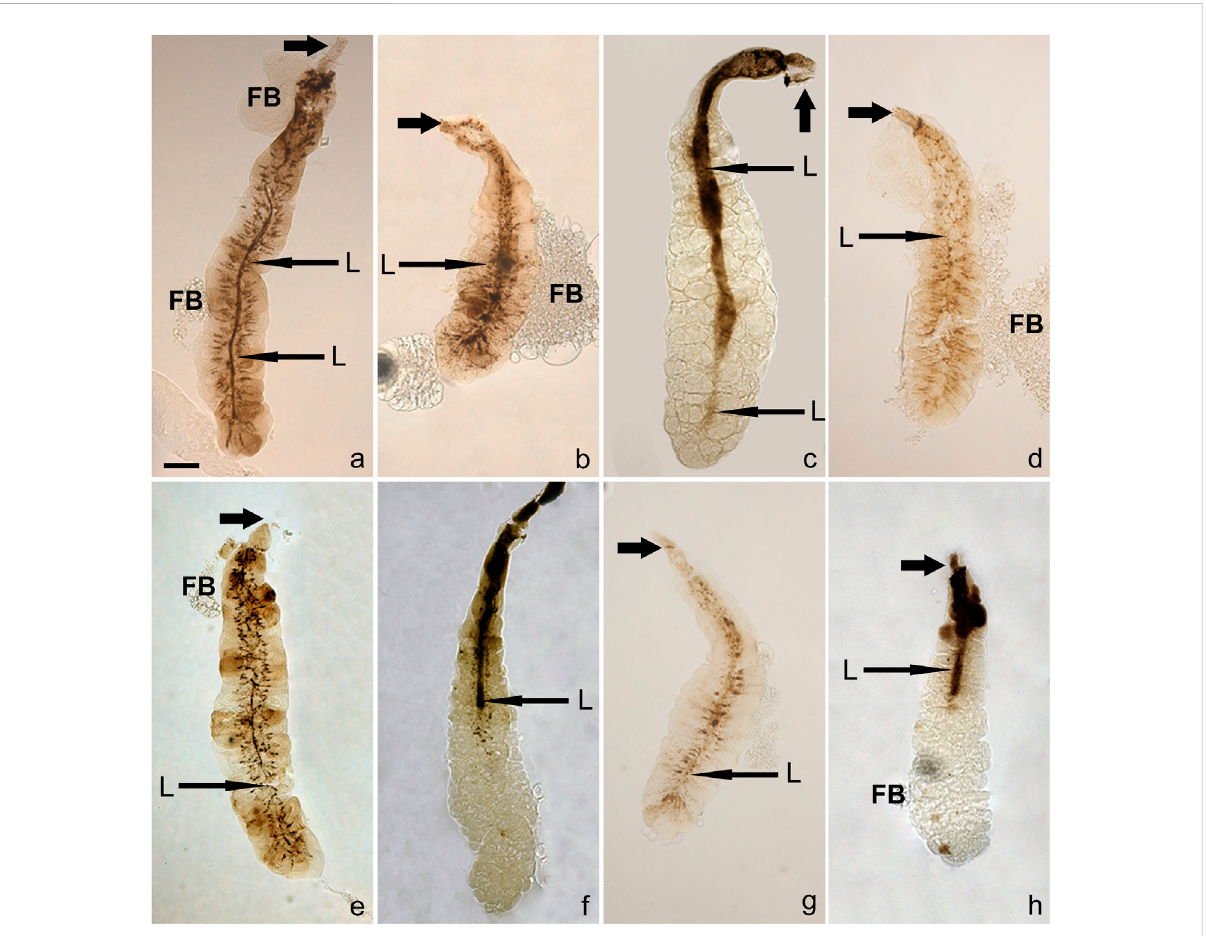
FIGURE 4 Post-apocrine concrements are found in the lumens of very late prepupal and/or early pupal SGs of eight species (A) D. willistoni , (B) D. subobscura , (C) D. mojavensis , (D) D. albomicans , (E) D. eugracilis , (F) D. sulfurigaster , (G) D. immigrans and (H) D. equinoxialis . Long arrows indicate centrally located lumen (L), whereas short thick arrows point to anterior ducts. The scale bar in the lower left corner of (A) represents 100 microns. Legend: D, duct, FB, adhering fat